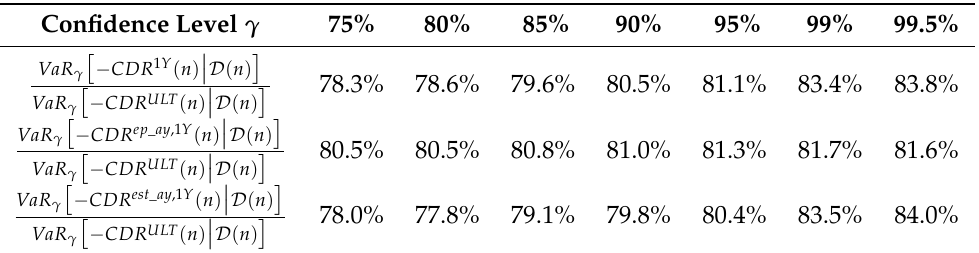
Table 2. The quantiles of the distributions of the one-year loss derived with three methods—the case without the estimation